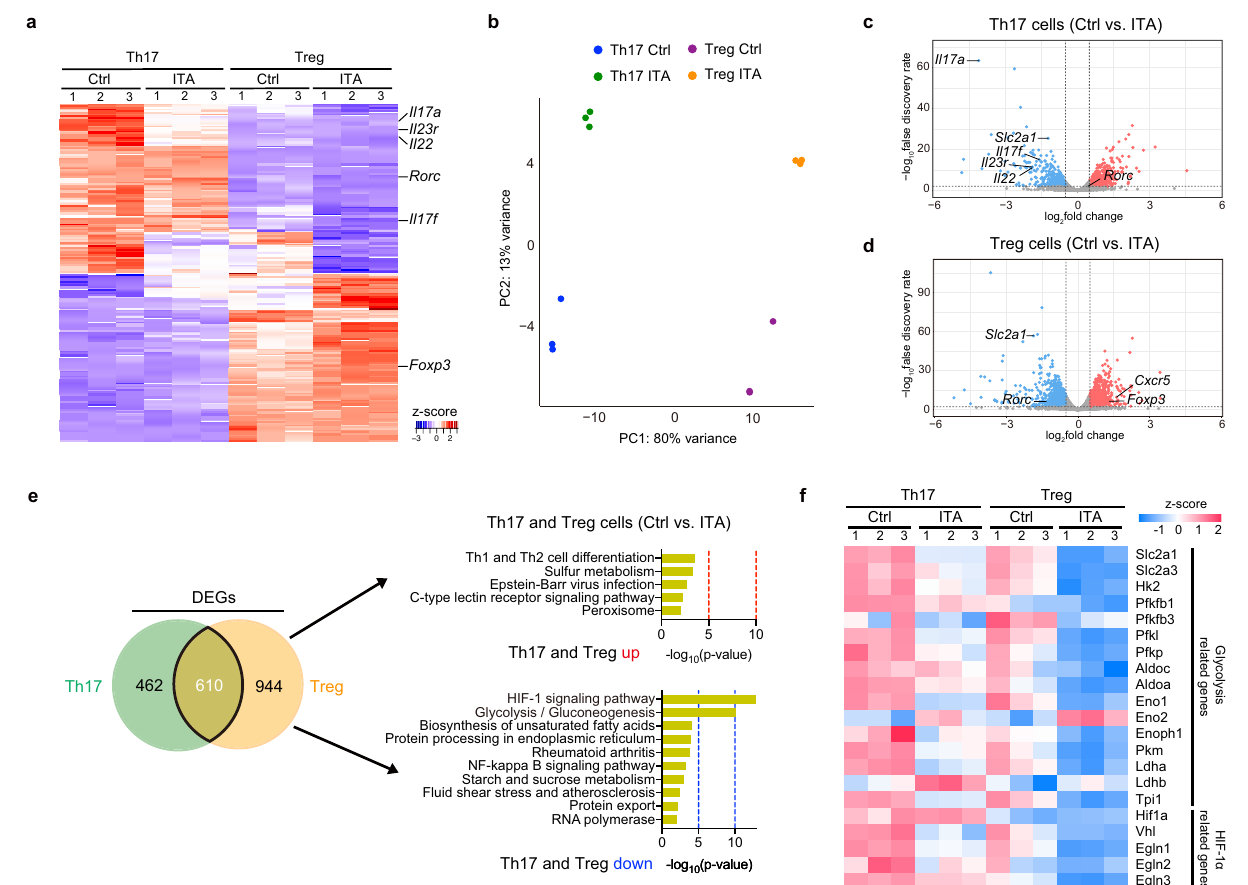
Fig. 3 | Itaconate decreases glycolysis-related genes under Th17- and Treg- polarizing conditions. a – f Th17- and Treg-polarizing T cells from B6 mice in the presence or absence of itaconate (ITA) after 2 days of culture were subjected to RNA sequencing ( n =3 in each condition, independent experiments). Heatmap ( a ) showsthetop100andbottom100modi fi edgenesfromRNA-seqinTh17-(left)and Treg- (right) polarizing T cells in the presence or absence of ITA. Principle com- ponent analysis of global gene expression from RNA-seq in four T cell populations ( b ).VolcanoplotofdifferentialgeneexpressioninITA-treatedTh17-( c )orTreg-( d )